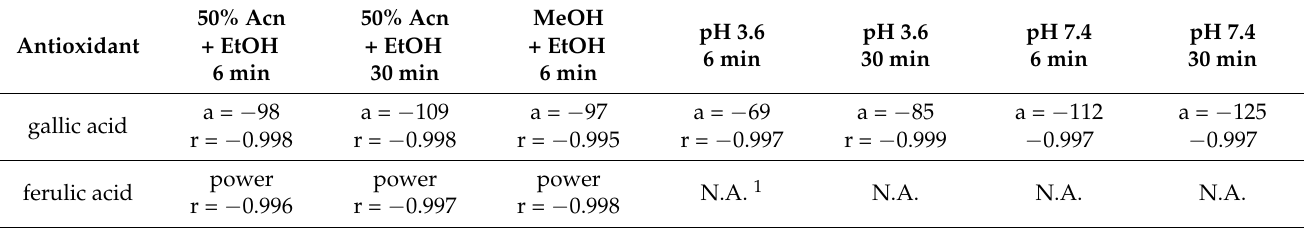
Table 1. Linear and non-linear relationships obtained for different antioxidant concentrations ( µ